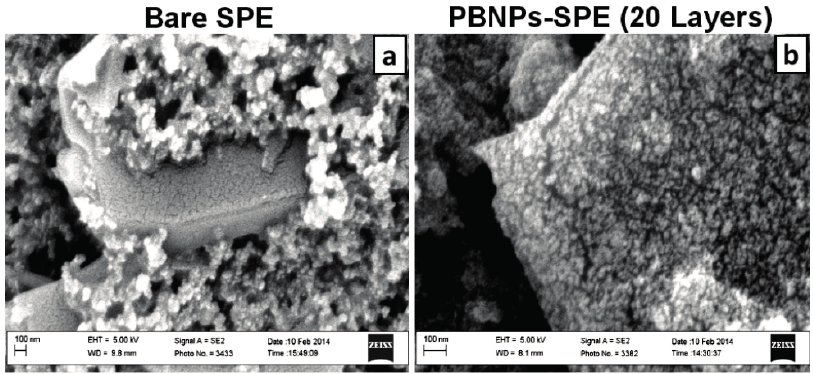
Figure 3. Scanning electron micrographs of ( a ) bare SPE and; ( b ) SPE modified with 20 inkjet-printed layers of PBNPs. Acceleration voltage: 5 keV, magnification 10